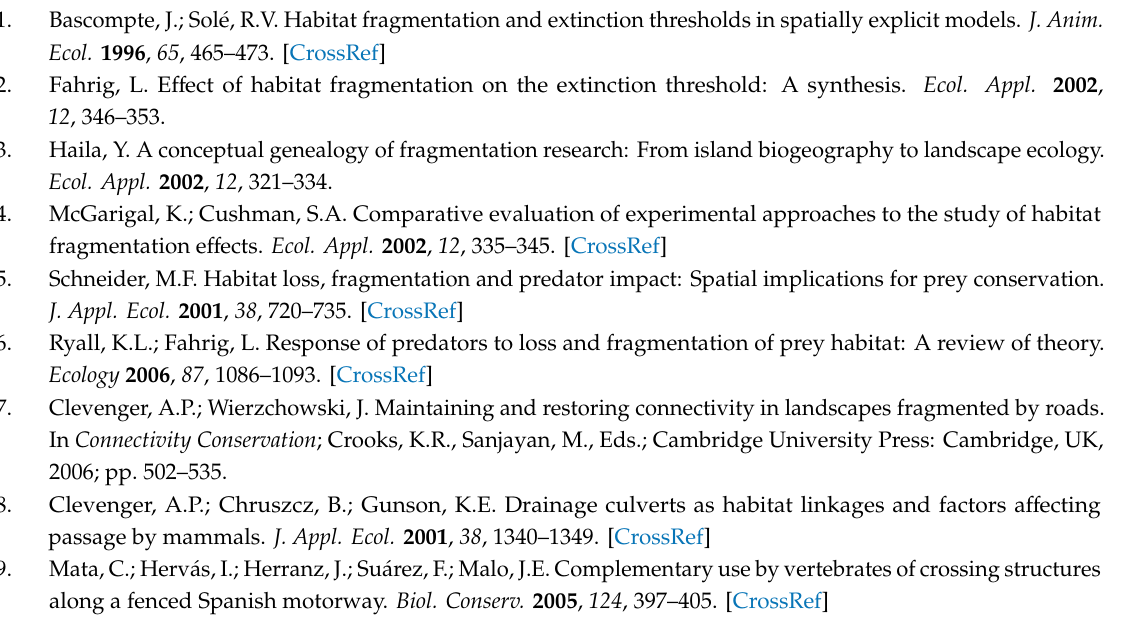
166 / s1: Figure S1: Study area location, Table S1: Characteristics of the monitored crossing structures: type, location and dimensions., Table S2: Model comparison and probabilities associated to parameters ϕ and / or δ included in the most informative models for each predator-prey